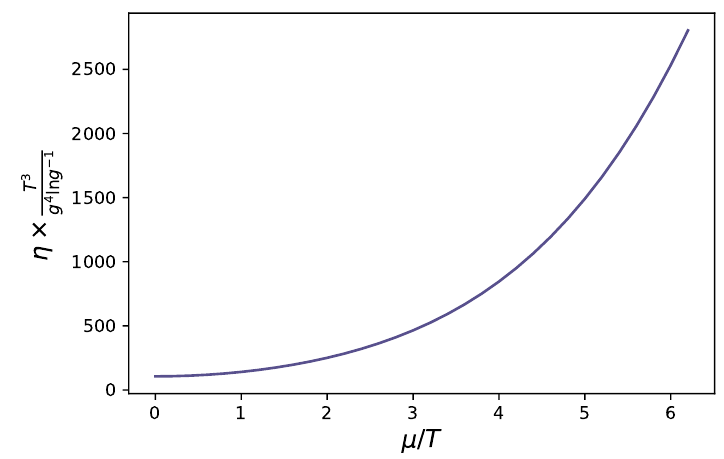
Figure 6 . Shear viscosity, normalized to the temperature, for a 6-function basis, 3 flavors of quarks and N c = 3 , as a function of chemical potential. For µ = 0 we recover the value obtained in ref.